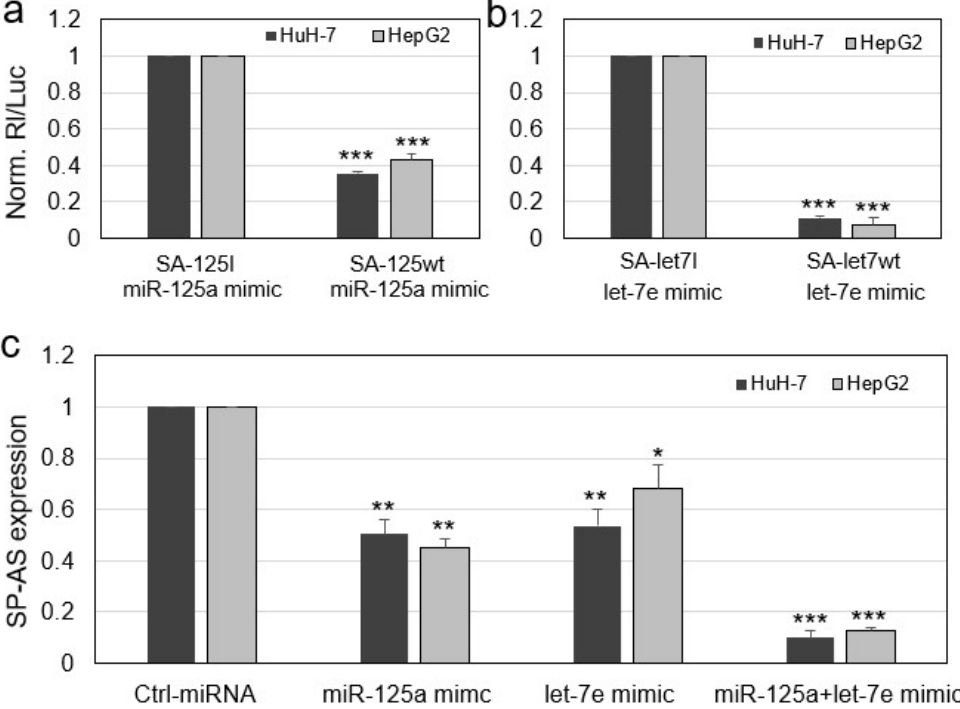
Figure 3. Validation of the binding between SP-AS and miR-125a or let-7e sequences. ( a , b ) Renilla luciferase reporter vectors carrying a control inverted target sequence (SA-125I or SA-let-7I) or the SP-AS target sequence for miR-125a or let-7e (SA-125wt or SA-let7wt) were co-transfected in HuH-7 or HepG2 cells along with miR-125a or let-7e mimics. Renilla luciferase activity (Rl) was normalized to that of firefly luciferase activity (Luc), whose coding sequence is carried by the same reporter vector, and the uninhibited activity related to the controls was set to 1. ( c ) Endogenous SP-AS expression was evaluated by RT-QPCR 48 h after transfection of HuH-7 or HepG2 cells with an unrelated miRNA mimic (Ctrl-miRNA) or miR-125a mimic, and let-7e mimic or both miRNA mimics. Data are reported as mean ± s.d. of replicate analyses. * p < 0.01, ** p < 0.01, *** p < 0.001 at Student’s t -test by comparison of indicated data sets to their respective controls.